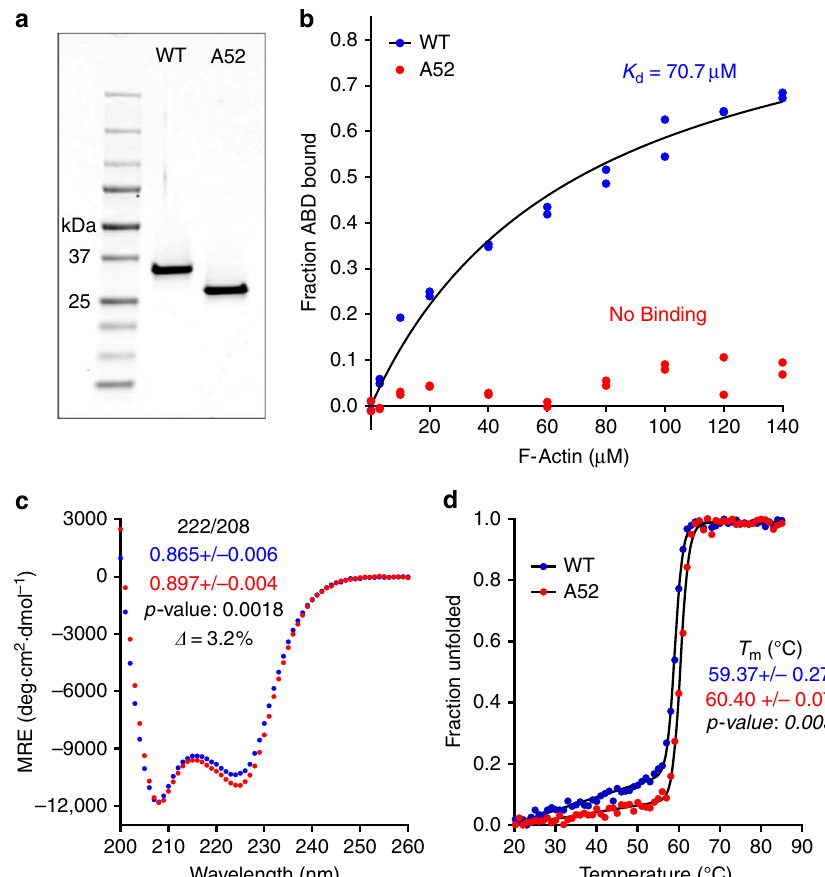
Fig. 2 The β -III-spectrin N-terminus is required for actin binding. a Coomassie blue stained gel of puri fi ed WT ABD or WT ABD without the N-terminal 51 amino acids (A52). b F-actin co-sedimentation assays showing that the N-terminal truncation abolishes actin af fi nity. c CD spectra demonstrating α -helical absorption pro fi les. The A52 ABD has a statistically signi fi cant increase in helicity ( n = 3). d CD denaturation at 222 nm. The A52 ABD has a statistically signi fi cant increase in T m ( n =